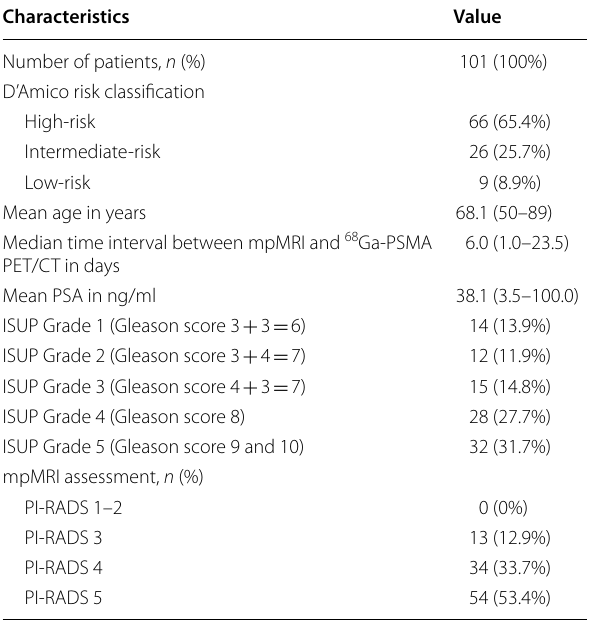
Table 1 Characteristics of the included prostate cancer patient population ( n 101) =